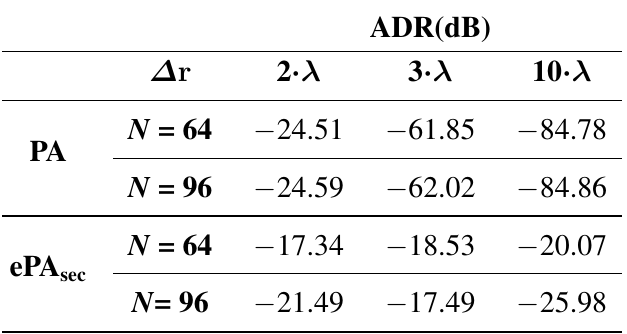
for array sizes of sec